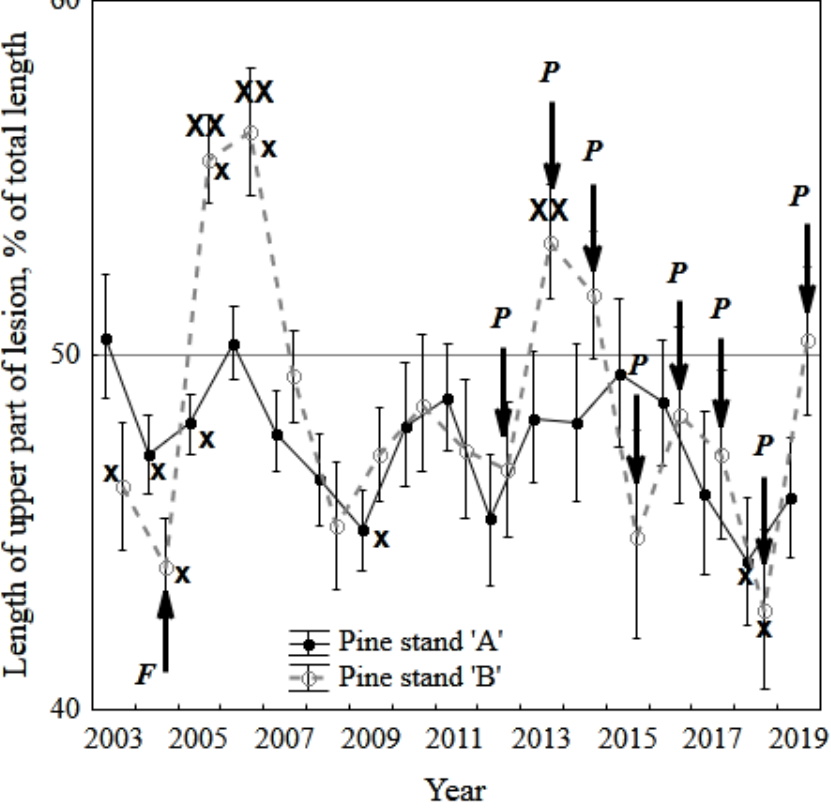
Figure 7. Shift of phloem necrosis relative to inoculation holes. Acute or chronic impacts were caused by the thermal factor ( F , a creeping fire) or chemical factor ( P , pollutants), respectively. “XX“ marks a significant difference between pine stands ‘A’ and ‘B’ ( p < 0.05 by the t -test), and “x” between the sizes of the upper and lower parts of necrosis according to the t -criterion ( p < 0.05). Average values for 30–40 trees and their standard errors are shown.